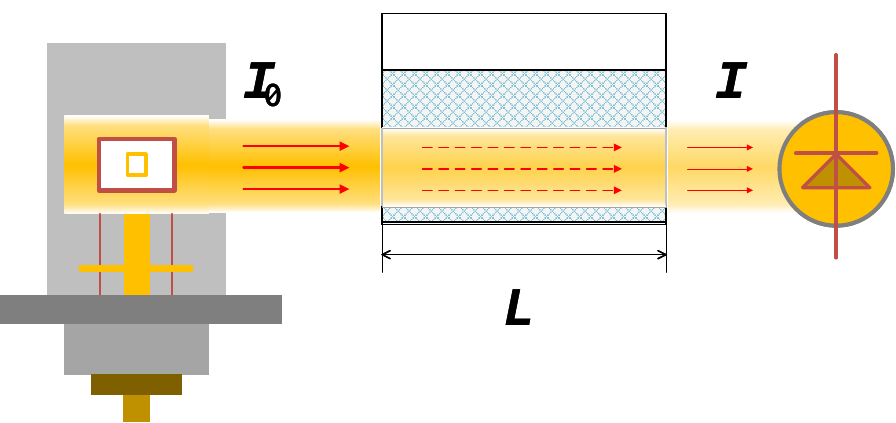
Figure 1. Schematic diagram of Lambert–Beer